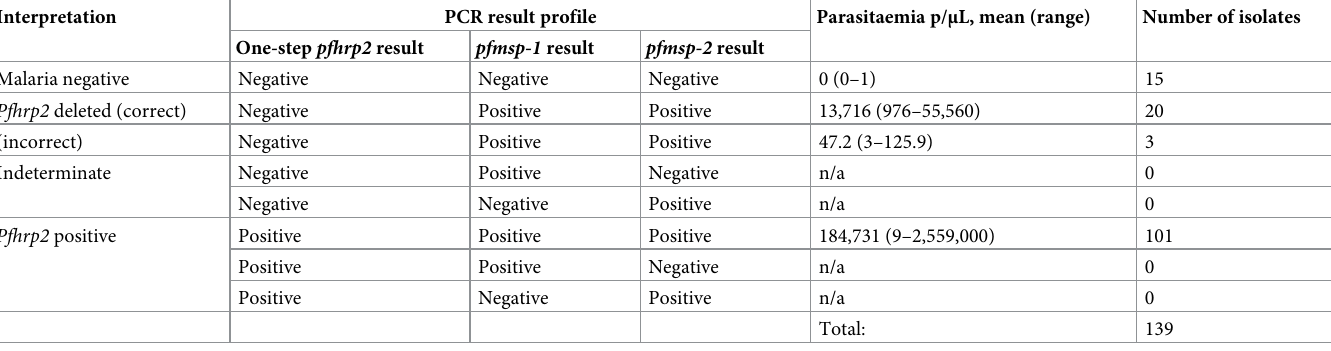
Table 5. pfhrp2 deletion classification according to one-step pfhrp2 PCR and single copy gene